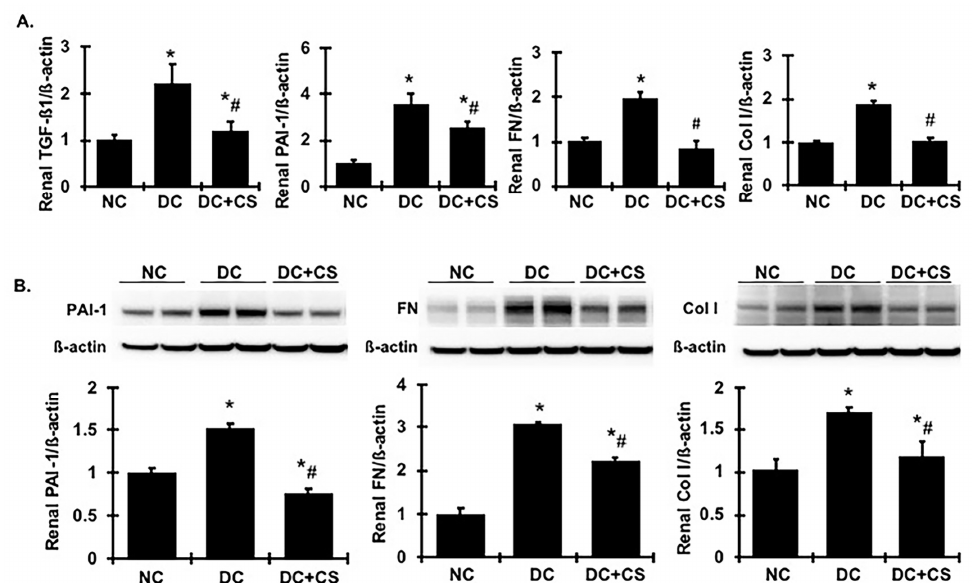
Figure 5. rBMSC sheets reduce renal mRNA expression and protein production of profibrotic markers in CGN rats. ( A ) Expression of TGFß1, PAI-1, FN, and Col I mRNA. Expression of mRNA was determined by real-time RT/PCR. Changes in mRNA levels were determined by first correcting the amplification of ß-actin for each sample. ( B ) Representative Western blots illustrating PAI-1, FN, Col I, and ß-actin protein expression in renal cortical tissues. The graphs summarize the results of band density measurements for PAI-1, FN, and Col I. * vs. normal control rats (NC), p < 0.05; # vs. disease control rats DC, p < 0.05. DC + CS, diseased rats received rBMSC sheets transplantation.